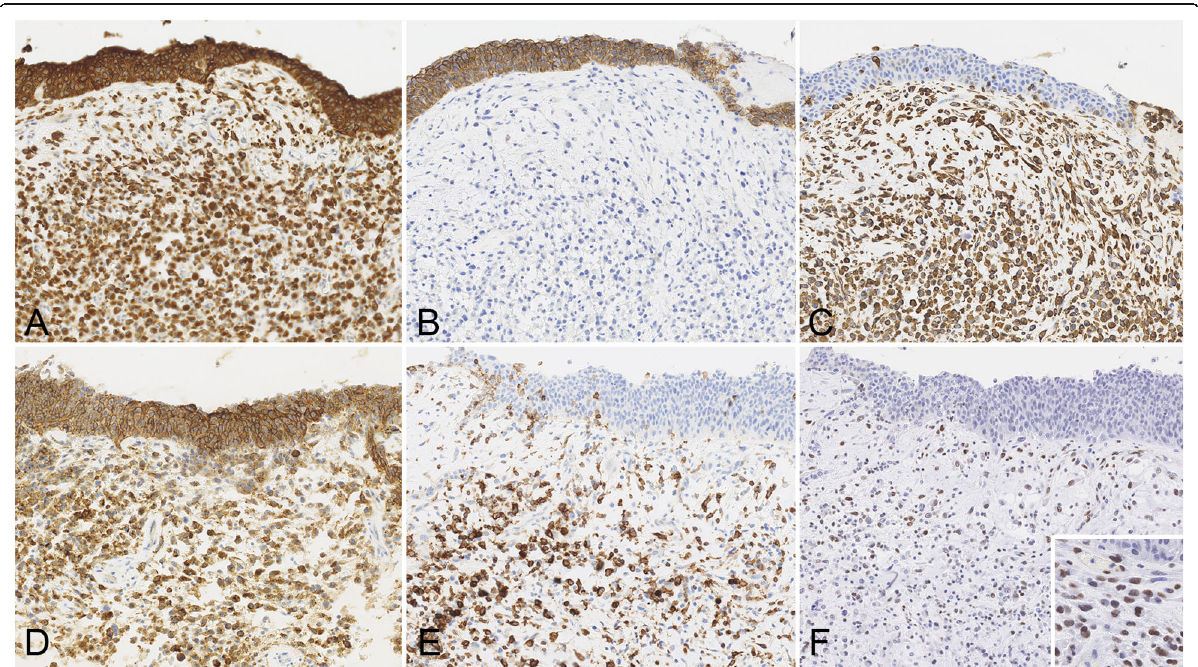
Fig. 2 Immunohistochemical analysis of the plasmacytoid urothelial carcinoma. Immunoreactivities of cytokeratin ( a ) and E – cadherin ( b ) in the urothelial carcinoma in situ were seen. In contrast, the expression of vimentin ( c ), CD38 ( e ), and ZEB – 1 ( f ) was only observed for the invasive plasmacytoid component. ZEB – 1 ( f ) was expressed in the nucleus of the plasmacytoid tumor cells. CD138 ( d ) was positive for both the urothelial